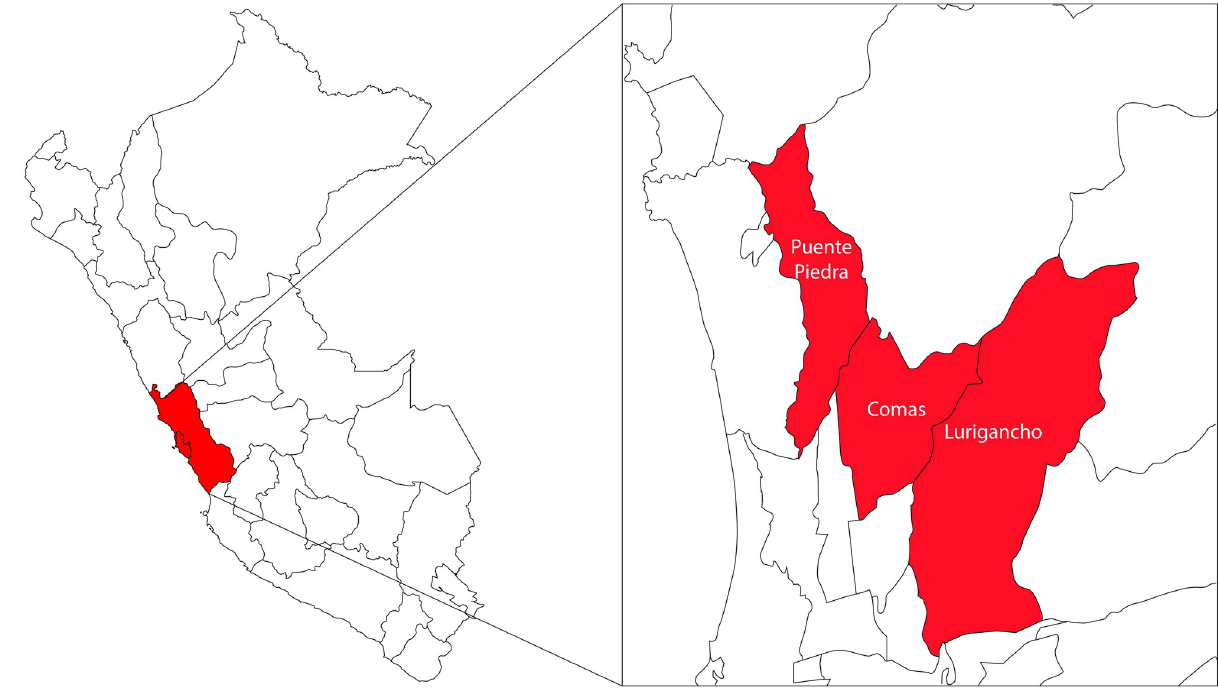
Fig 1. Geographic location of the selected districts in Lima, Peru.